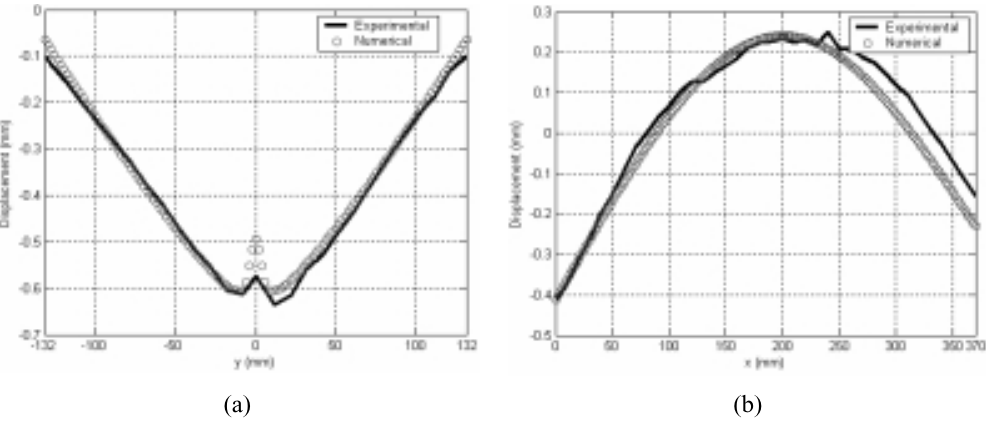
Fig. 9. Final deformed shape on the upper face of plate 1 of sections x = 50 mm (a) and y = 112 mm (b).